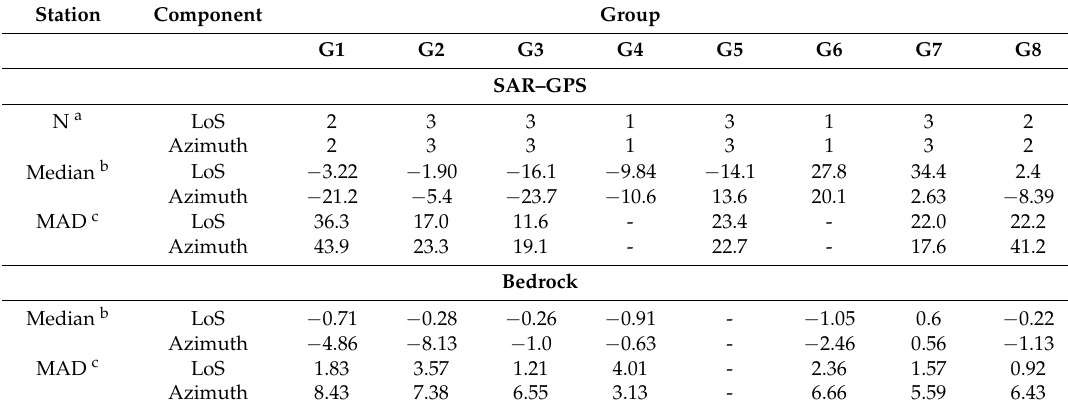
Table 10. Task 4 validation